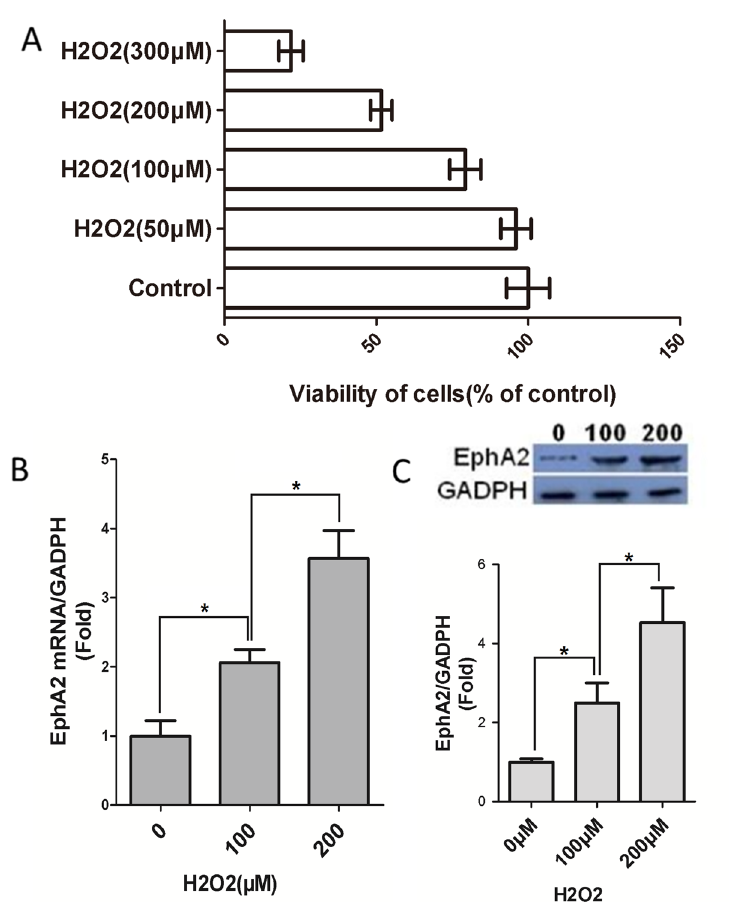
O repressed cell viability and enhanced EphA2 expression in SRA01/04 cells. SRA01/04 cells were treated with different concentration Figure 1 – H 2 2 of H O (50, 100, 200, 300 μM) for 24 h. (A) CCK-8 assay was performed to examine cell viability of SRA01/04 cells. (B-C) QRT-PCR and WB were 2 2 performed to examine the gene and protein expression of EphA2 in SRA01/04 cells. * P < 0.05, vs. Control or 0 or 100